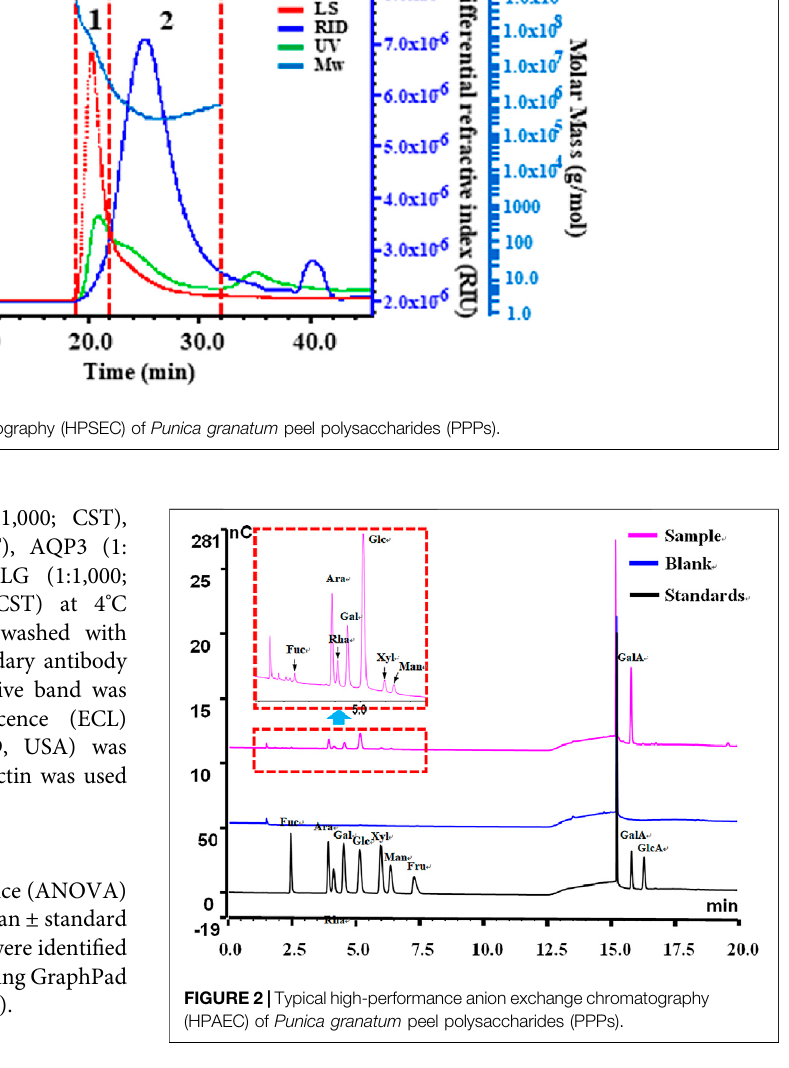
Frontiers in Pharmacology |